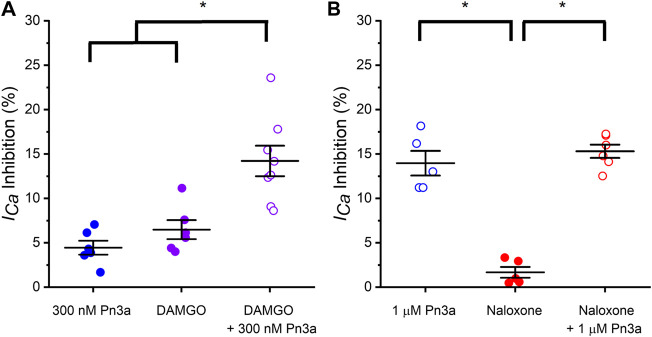
Pn3a and opioids inhibit rat DRG neurons high voltage-activated I
Ca. (A) Bar graph summary of I
Ca modulation by OR agonist DAMGO and Pn3a in small IB4
− DRG neurons. 300 nM Pn3a (⊚; n = 6), 100 nM DAMGO (⊚; n = 6), 100 nM DAMGO +300 nM Pn3a (⊚; n = 8) (B) Bar graph summary of I
Ca modulation by OR antagonist DAMGO and Pn3a in small IB4
− DRG neurons. 1 µM Pn3a (⊚; n = 5), 1 µM naloxone (⊚; n = 5) and 1 µM Pn3a +1 µM naloxone (⊚; n = 6). One-way Anova results (* = p < 0.001).